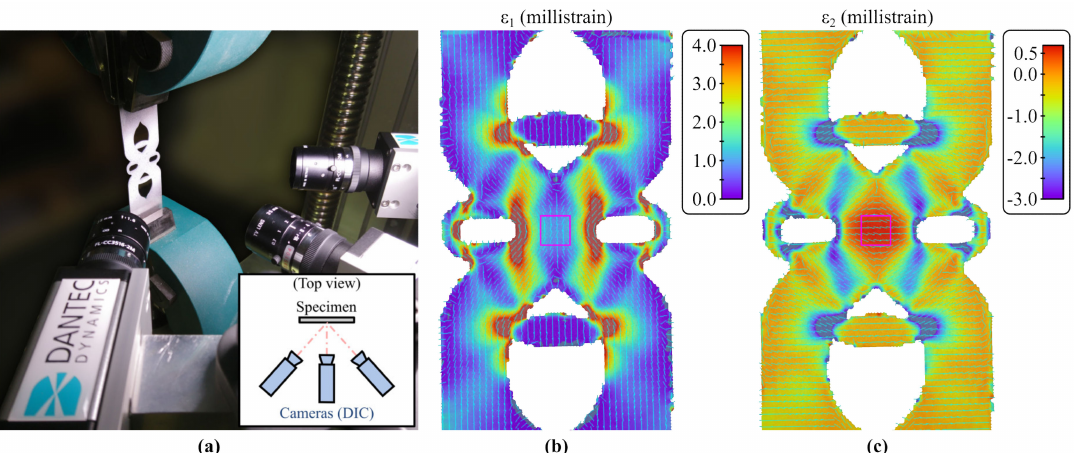
Figure 4. Heterogeneous specimen strain field measurement: ( a ) optical measurement system with a multi-cam configuration, ( b ) measured maximum principal logarithmic surface strain field contours ε 1 ( c ) measured minimum principal logarithmic surface strain field contours ε 2 .